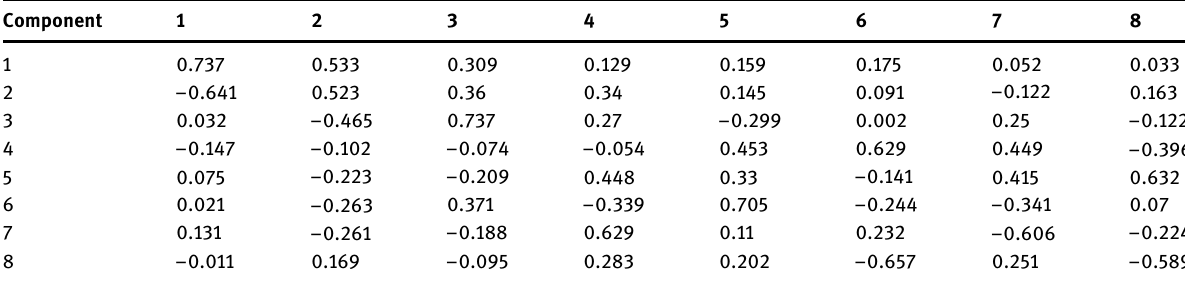
Table 8: Component transformation matrix for the eight excerpted components